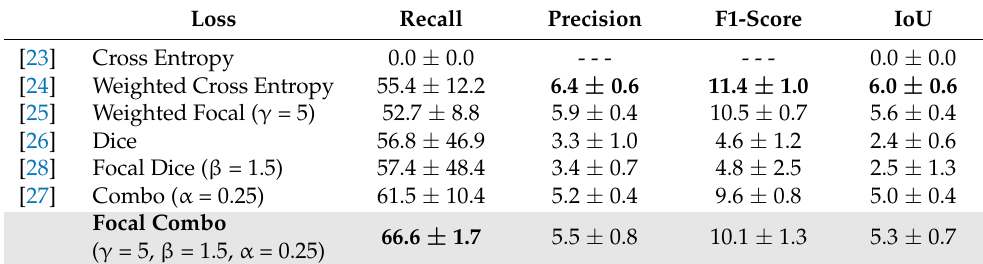
Table 3. Initial results for fast-SCNN in (%) for the road marking